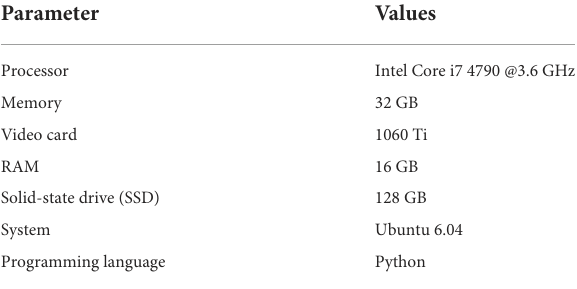
TABLE 4 Experimental